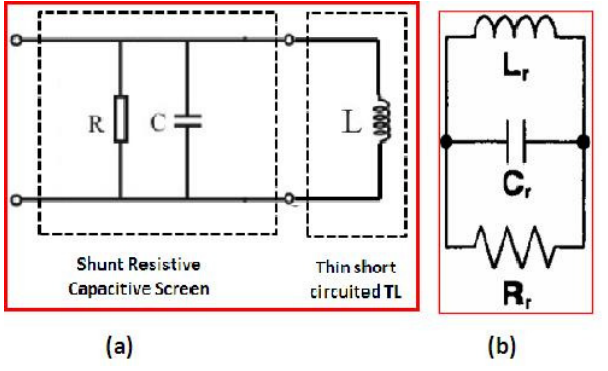
Figure 2: An equivalent circuit of the metamaterial transmission line RAM. (b) A SRR equivalent circuit.